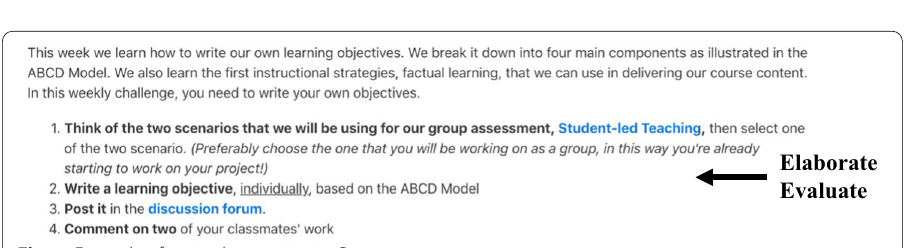
Fig. 3 Example of a pre-class activity in Course 1